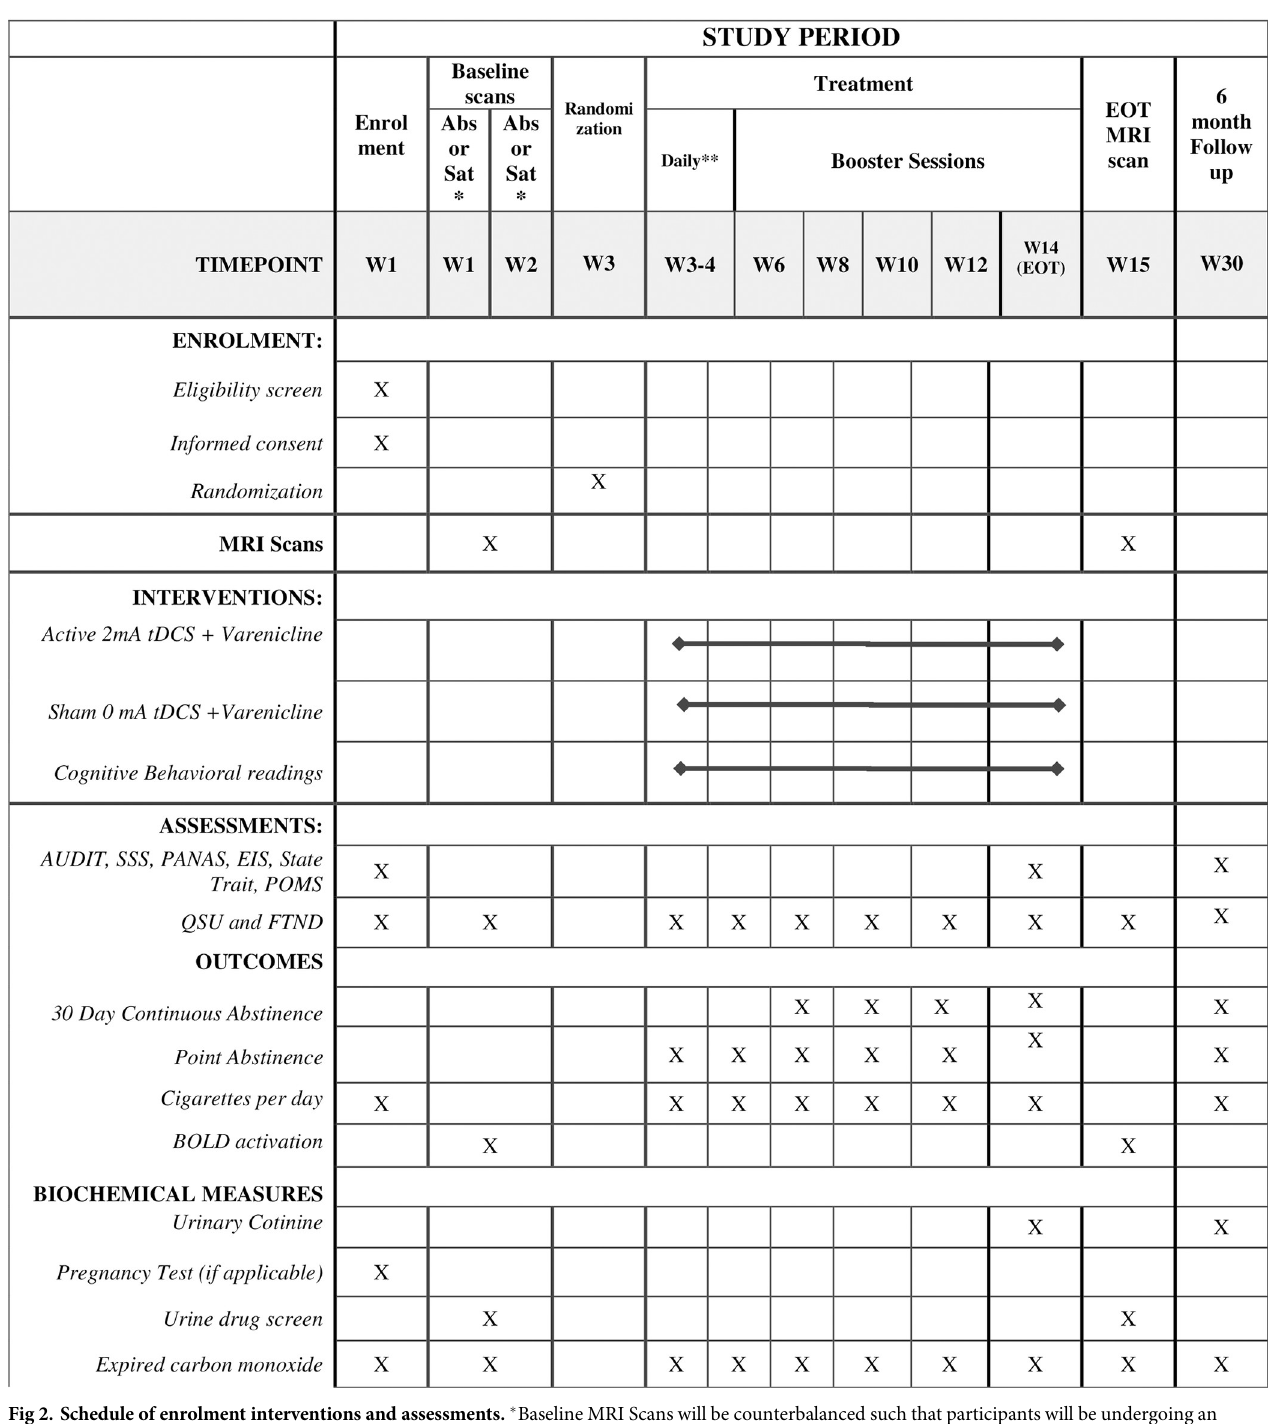
PLOS ONE | https://doi.org/10.1371/journal.pone.0277408 December8,